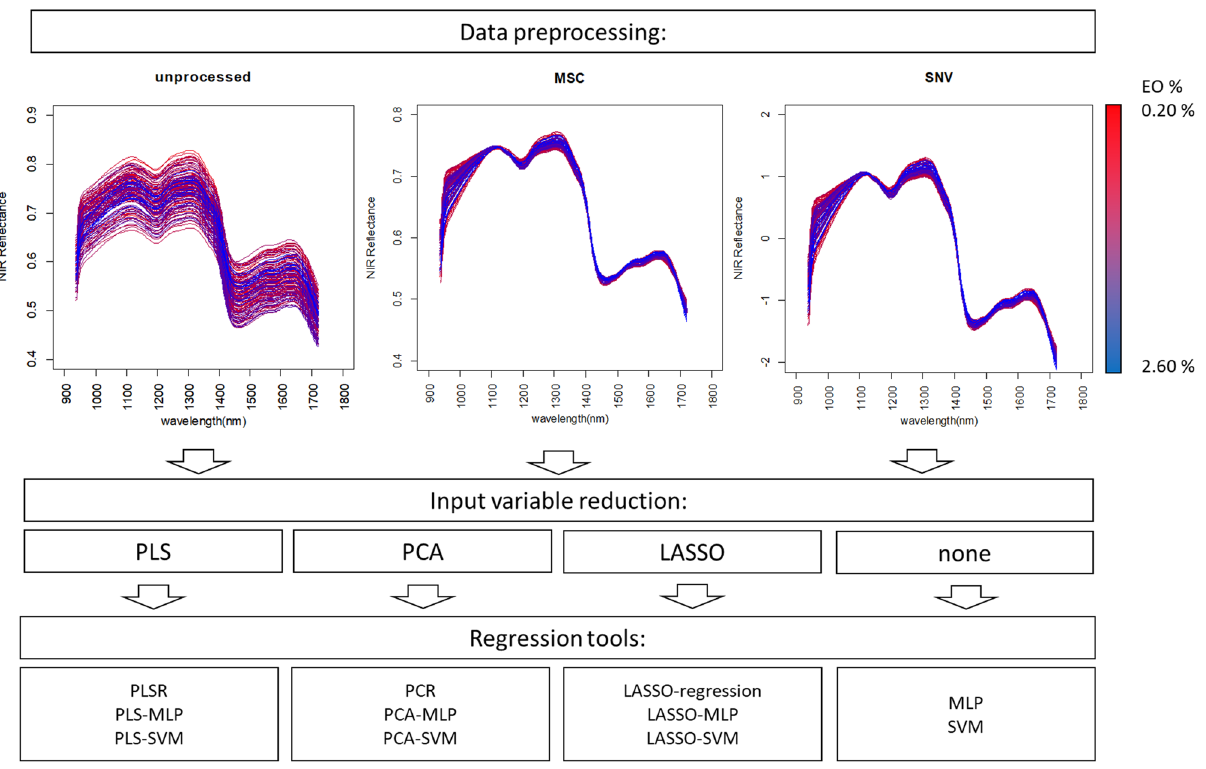
Figure 2. Overview of preprocessing, variable selection and regression tools used to predict the EO concentration in spearmint.